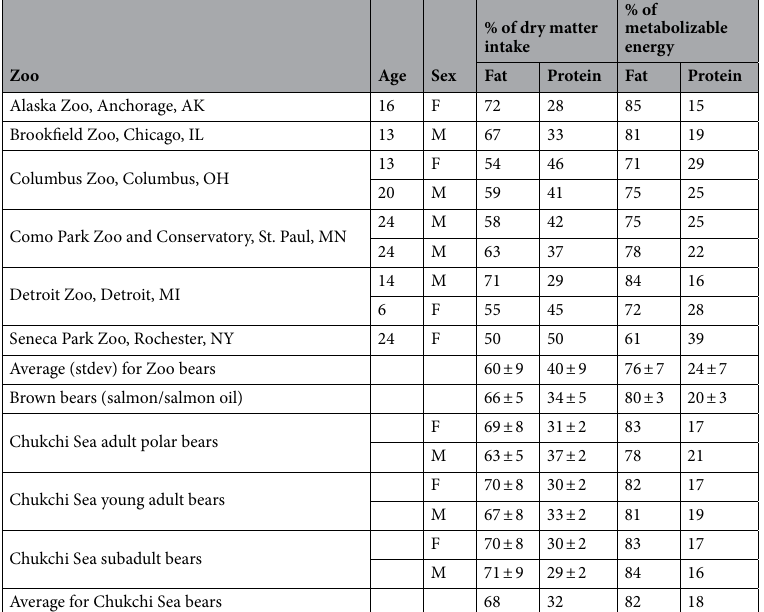
taining body mass (maintenance energy cost determined by solving the equation of the line in Fig. 1 for y = 0) of zoo polar bears than brown bears was expected due to the larger exhibits available for zoo polar bears to roam compared to the habitat for the captive brown bears in previous studies. Further, while efforts could be made to standardize energetic costs of brown bears in previous studies, such controls were not possible with zoo polar bears on exhibit. Thus, both wild and zoo polar bears selected protein and fat at levels consistent with minimizing maintenance energy costs and higher efficiencies of mass gain as previously observed in brown bears (Fig. 2).